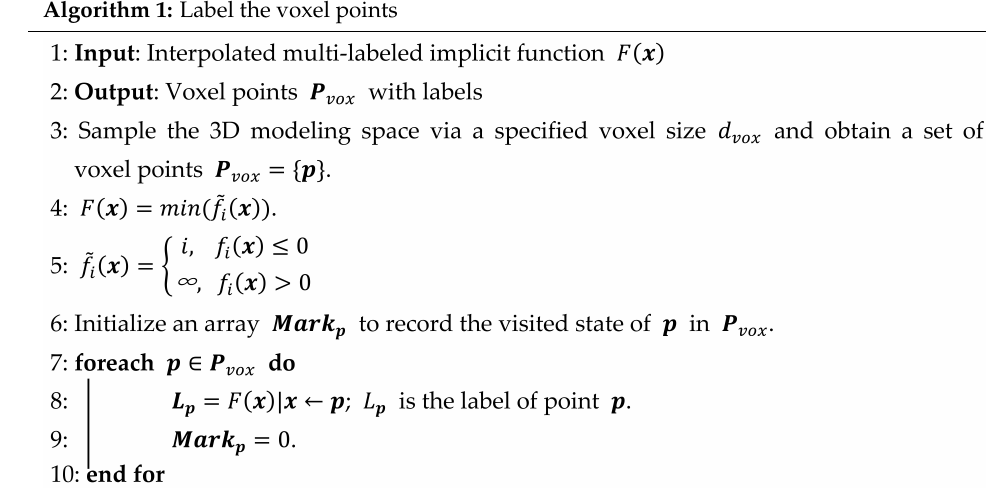
Algorithm 1: Label the voxel points